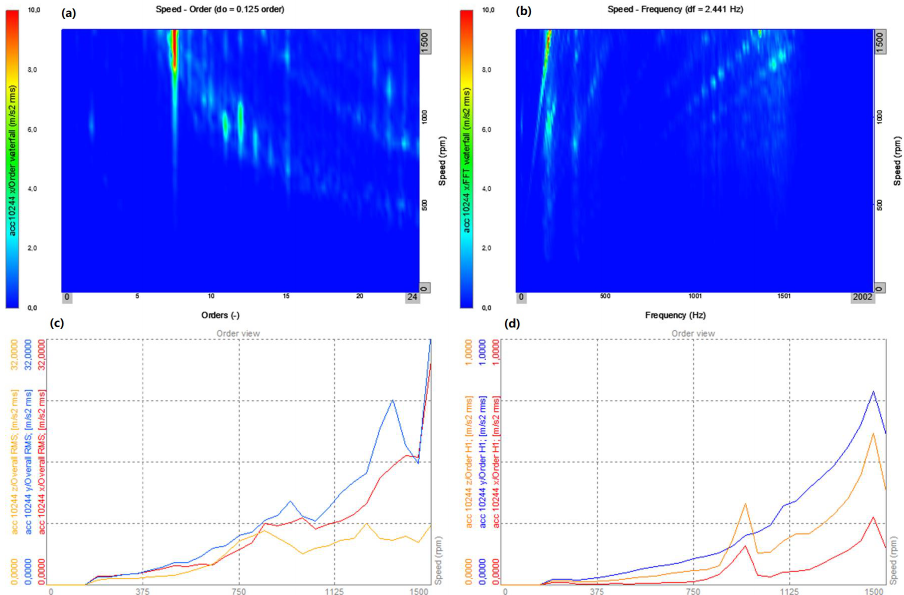
Figure 13. Start-up—locked coupling (left rotation): ( a ) top view on the plane: order–rotational speed (rpm); ( b ) top view on the plane: frequency–rotational speed (rpm); ( c ) amplitude changes all the harmonics as a function of the rotational speed (rpm) for the three directions ( x , y , z ); and ( d ) changes in the amplitudes of the first harmonic as a function of the rotational speed (rpm) for the three directions ( x , y , z ).